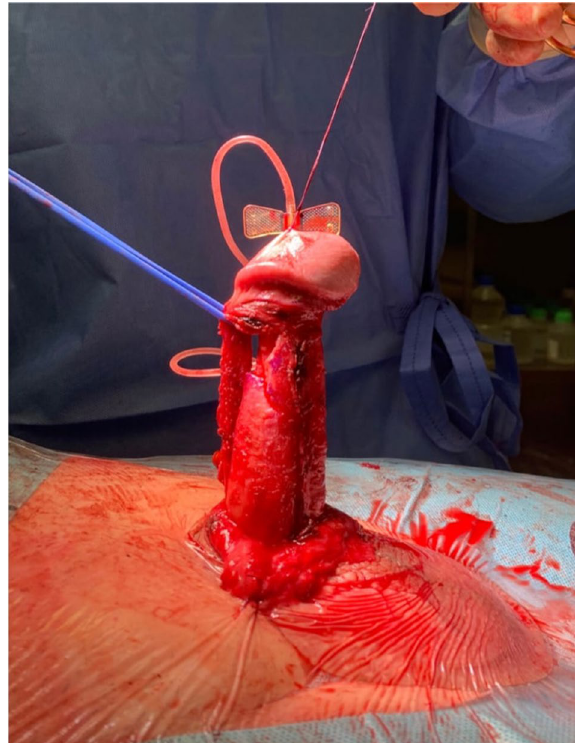
Figure 2. A standard double-Y relaxing tunical incision was performed to completely straighten the penile